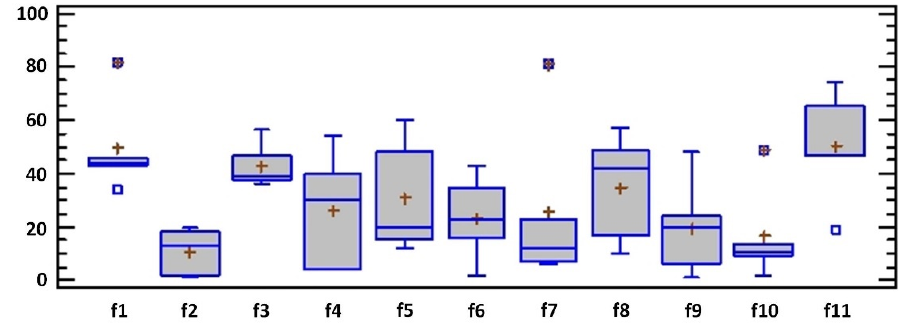
Figure 6. Box plot of 1 series of experiments.